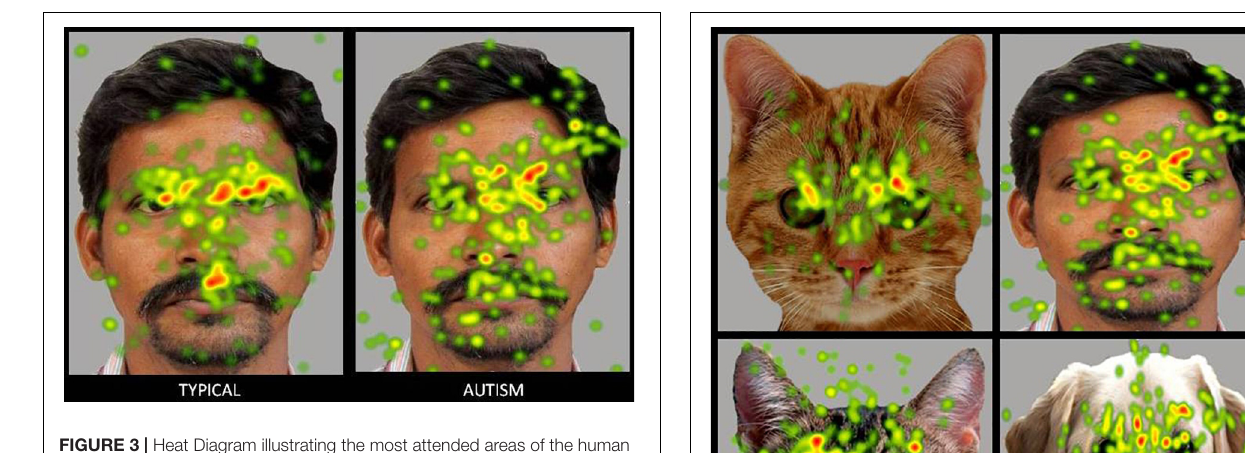
FIGURE 3 | Heat Diagram illustrating the most attended areas of the human face by Typical and ASD participants and the lesser attention to salient regions of the human face in ASD. (Gradients of most attended areas on the heat maps range from red through yellow to green).